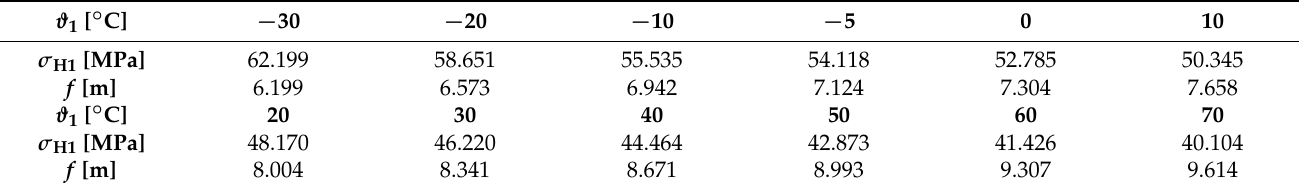
Table 2. The reference sag-tension table of the ACSR 240/39 conductor, symmetrical tower span of 300 m, weak icing area